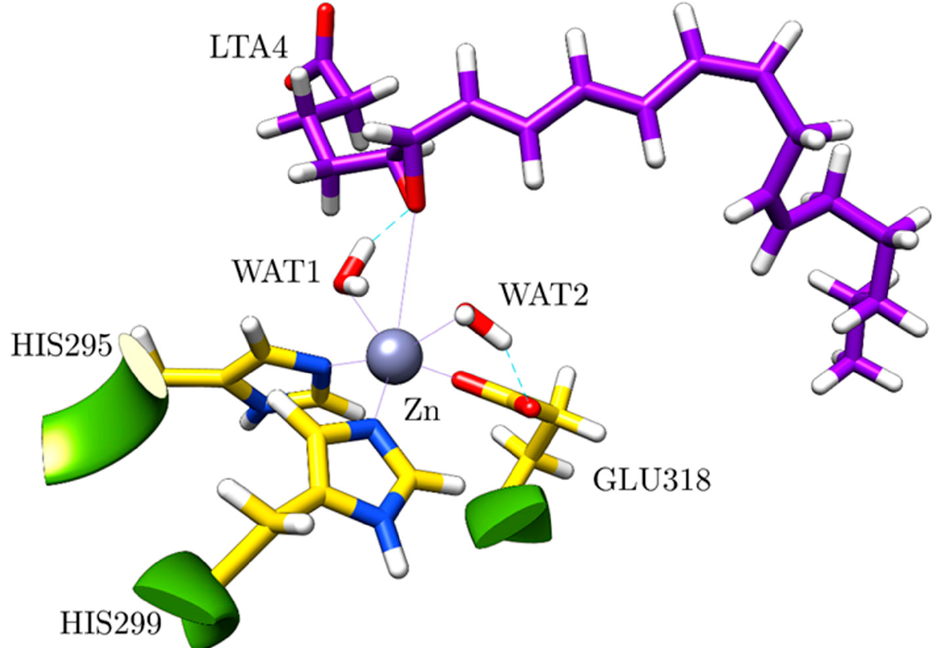
Figure 5. Zn environment in the optimised structure.